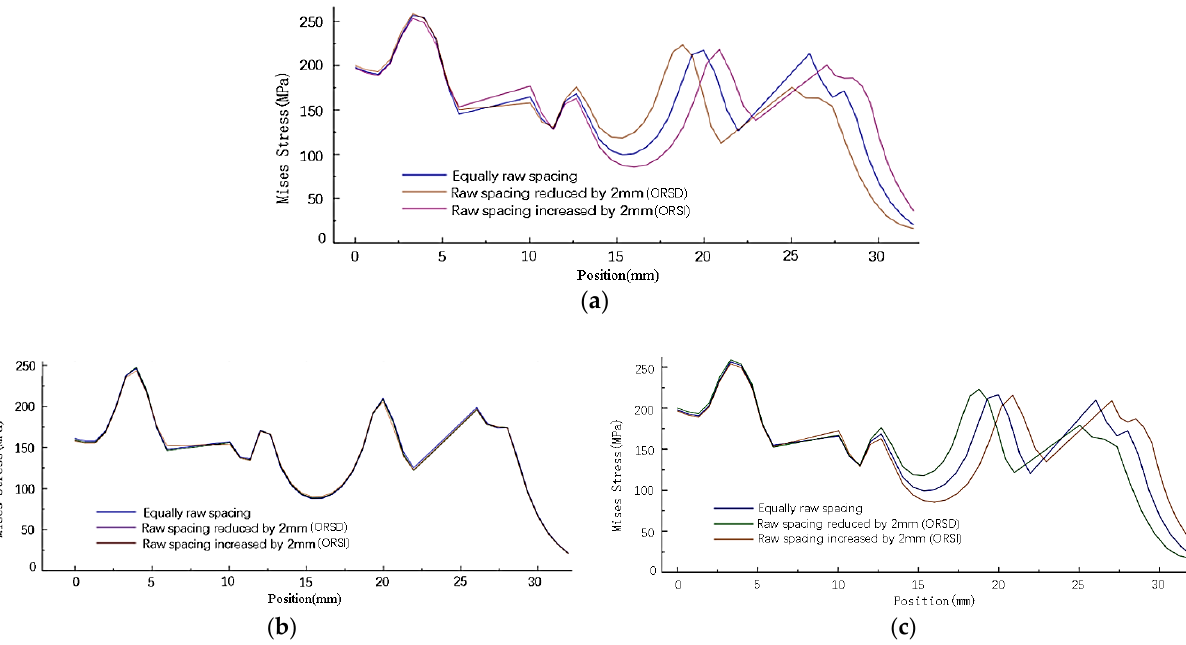
Figure 14. Stress distribution of the connector after stretching under changing the raw spacing of rivets: ( a ) stress distribution along path1; ( b ) stress distribution along path2; ( c ) stress distribution along path3.